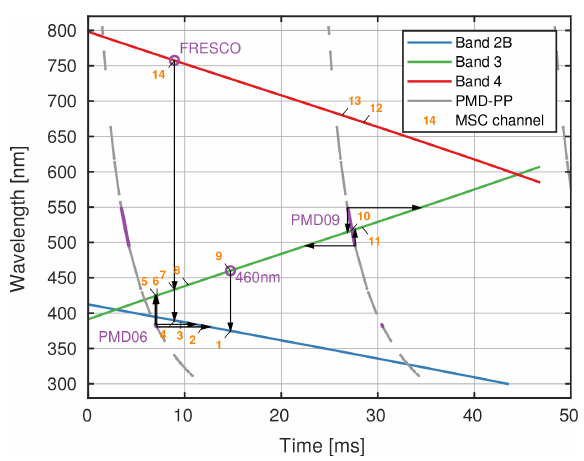
Figure 3. Spatial aliasing of GOME-2 for MSC and PMD bands in time–wavelength space. Radiometric and spatial correlation is ex- pected to be maximal at the respective intersections. Note that the PMD readout is faster (steep slope of gray lines) and at higher fre- quency compared to the MSCs. The second PMD readout ( m = 1) begins after 23.4375ms (EUMETSAT, 2015). Horizontal and ver- tical black arrows indicate the spectral and temporal mapping be- tween GOME-2 bands,